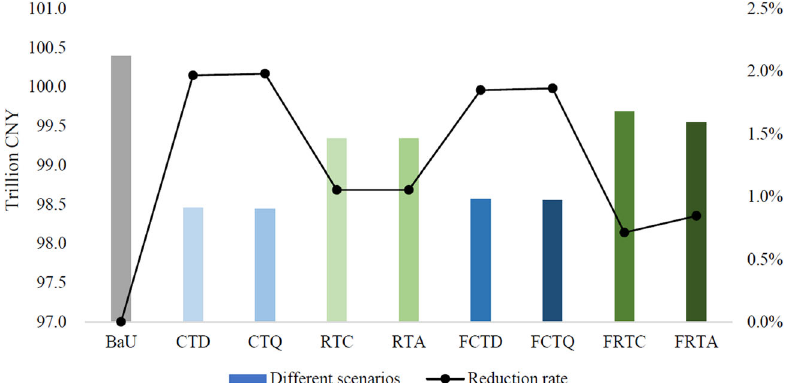
Fig. 3 GDP in 2030 and GDP loss rate compared with BAU scenario. Blue bars are scenarios imposing carbon taxes, and green bars are scenarios imposing resource taxes. Deeper colors represent free market condition in these scenarios. Please refer to Table 2 for industry abbreviations.